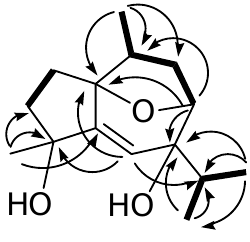
Figure 1. 1 H- 1 H COSY correlations (bold lines) and key HMBC correlations (H → C) of 1 .